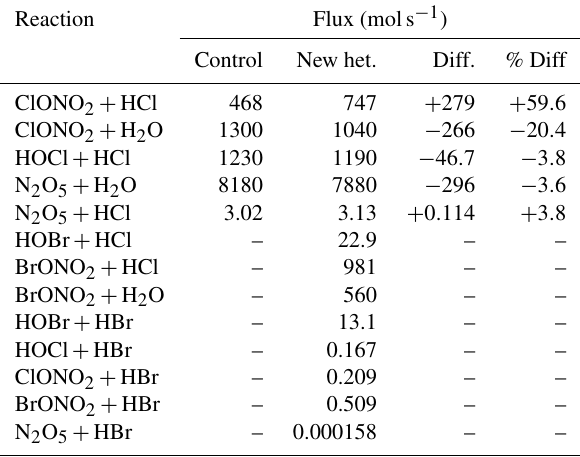
Table 2. Difference in heterogeneous reaction flux between “new het.” and control runs